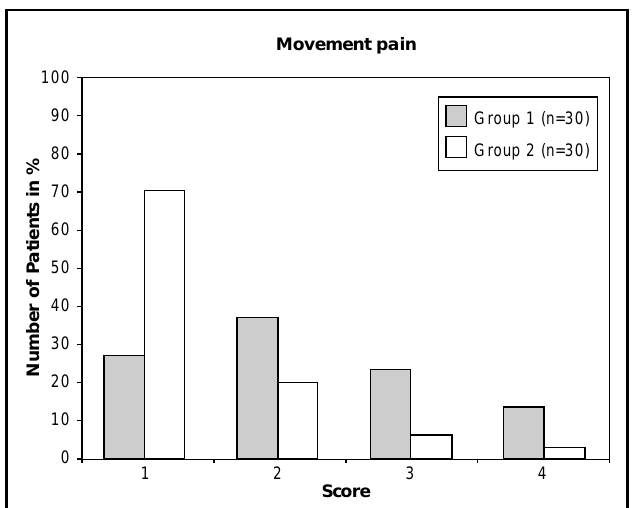
Figure 6: Distribution differences in resting pain at the end of six weeks of treatment in the therapy